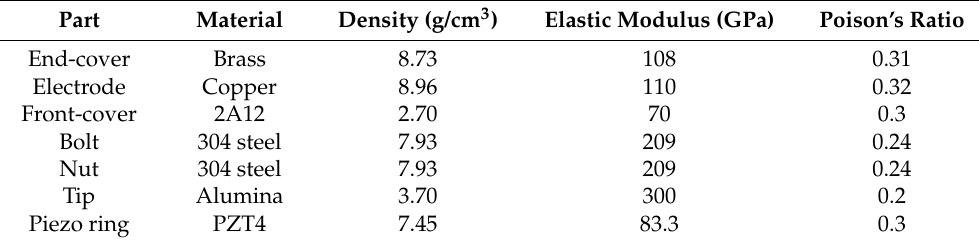
Table 1. Detail illustration of the material parameters of vibrator parts.